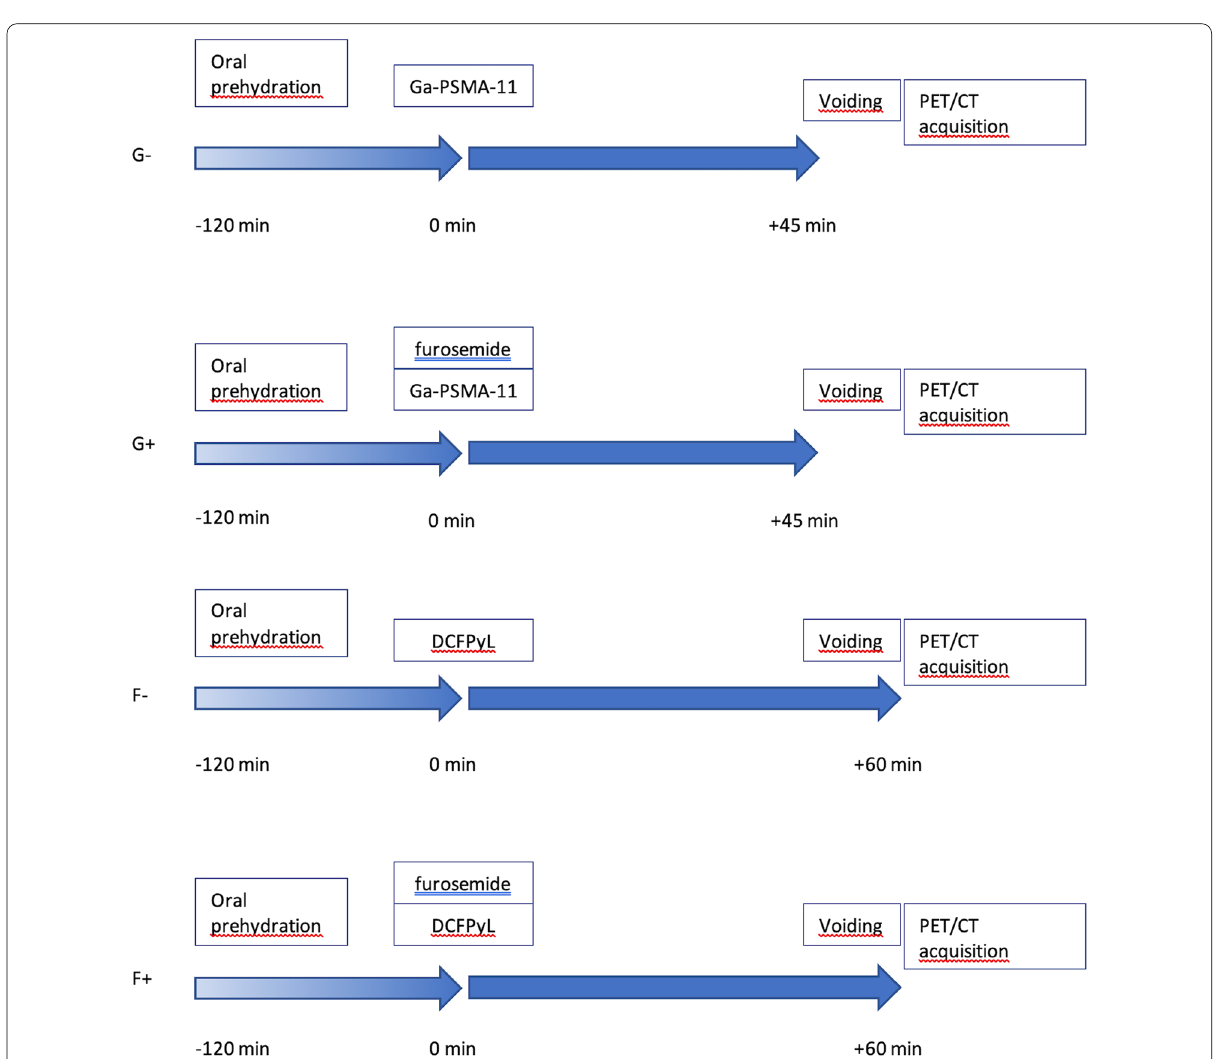
Fig. 1 Patient preparation and scanning protocol per cohort. 68 Ga‑PSMA‑11, no furosemide (G no furosemide (F ); 18 F‑DCFPyL and furosemide (F −